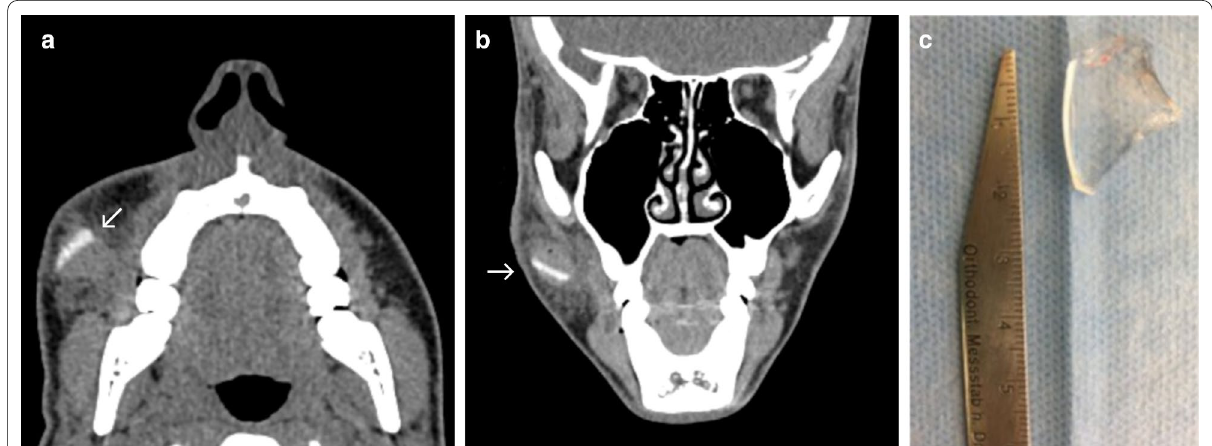
Fig. 11 Broken ophthalmic lens. Axial ( a ) and coronal ( b ) CT images showing a hyperdense foreign object (arrow) in the right buccal area surrounded by haematoma. Photograph of a translucent piece of glass after surgical retrieval ( c )